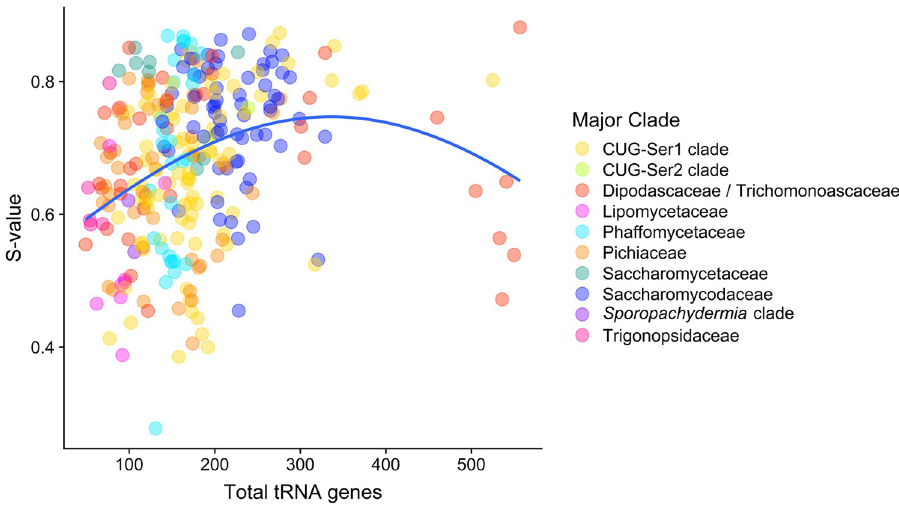
Fig 7. Maximum translational selection occurs at an intermediate number of total tRNA genes in the genome. This plot shows the relationship between the total number of tRNA genes in a genome (tRNAome size) and S-value for each the 327 budding yeast species analyzed in this study. The best fitting model (blue) was a Gaussian distribution with a maximum S-value at 336 tRNA genes. This suggests that species with either low or high numbers of total tRNA genes exhibit lower levels of translational